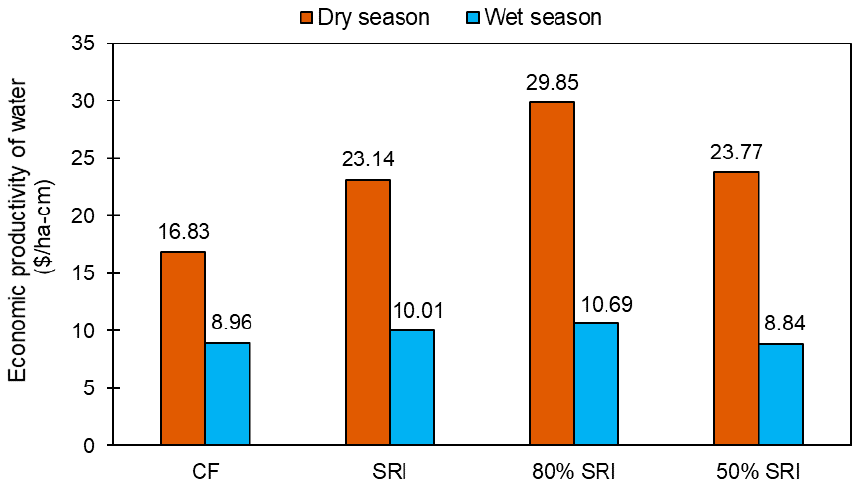
Figure 8. Economic productivity of water (US$/ha-cm) under different water management options during the dry and wet seasons. The CF is continuous flooding and SRI is system of rice intensification. 80% SRI and 50% SRI refers to 80% and 50% of the SRI ponding depth, respectively.